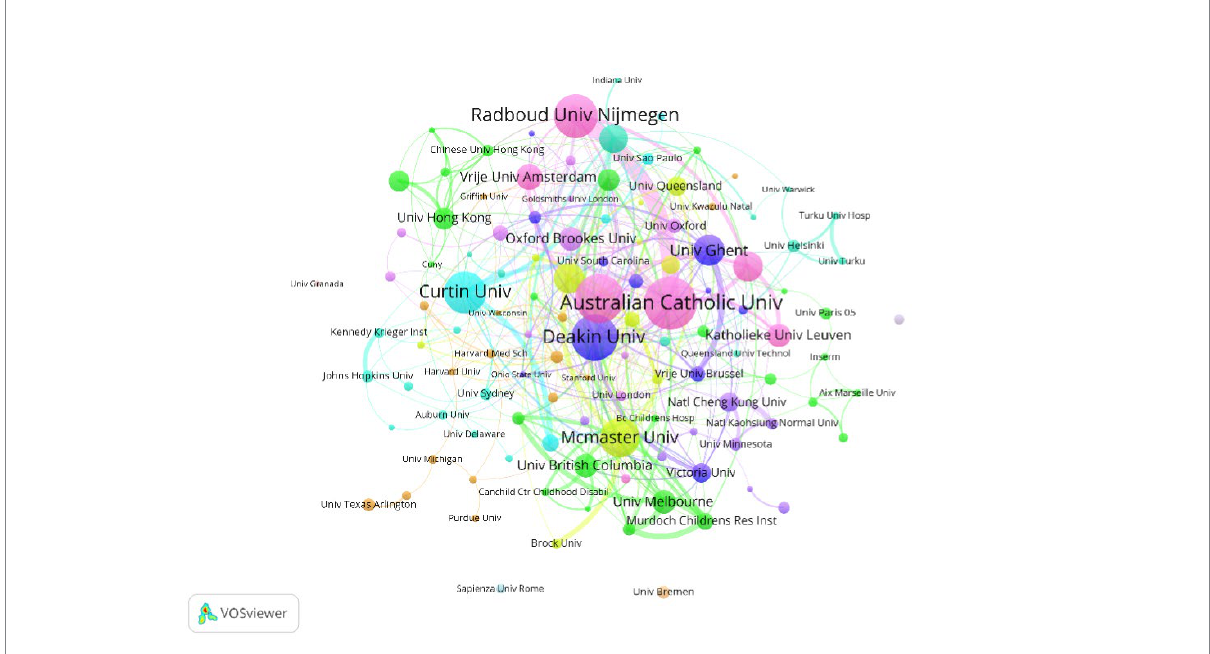
FIGURE 4 The cooperation network visualization map of institutions based on VOSviewer.